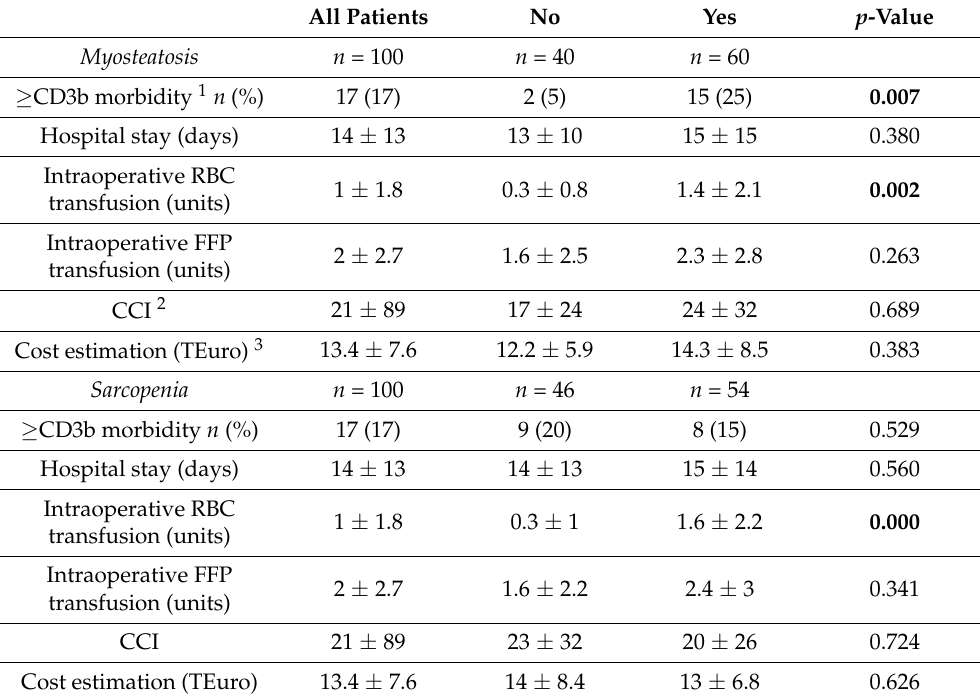
Table 3. Perioperative outcome stratified by body